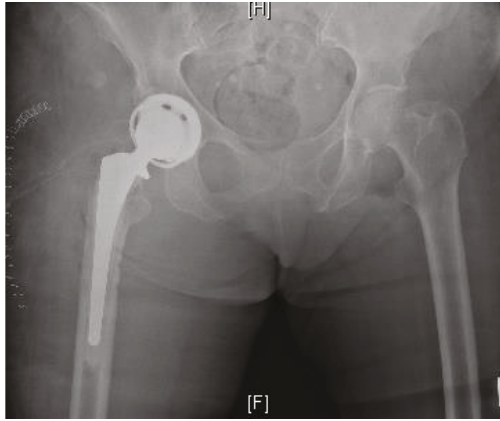
Figure 7: Anteroposterior (AP) pelvis radiograph, status post right hip irrigation and debridement, greater trochanter excision, hook plate, and cable removal of